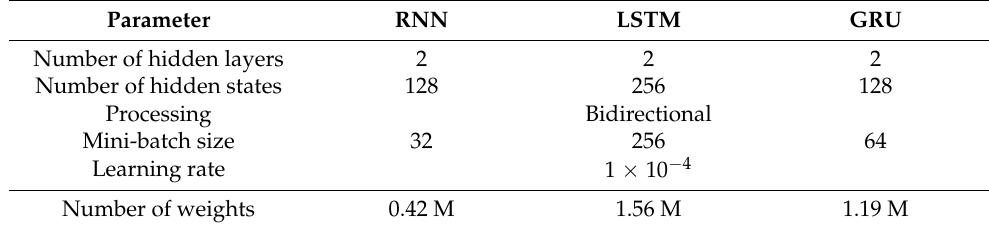
Table 2. Settings of three RNN-based neural decoders widely used in existing iBCIs. All the decoders were implemented with layer